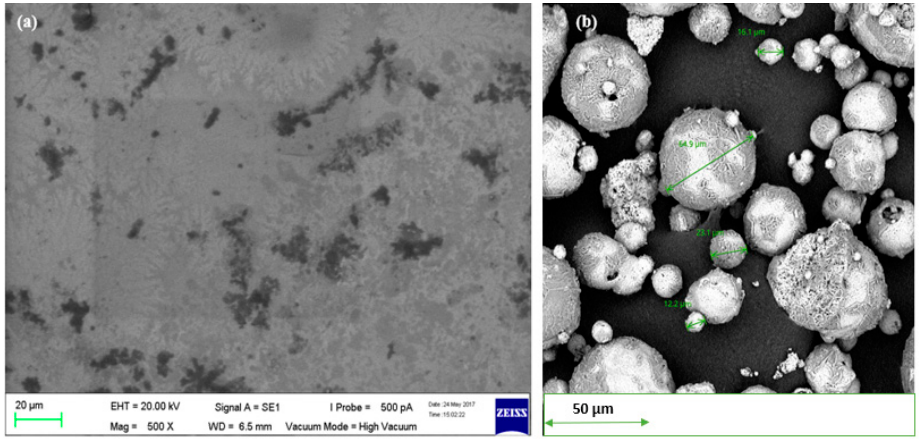
Figure 1. As-received Scanning Electron Microscopy (SEM) image: ( a ) Vit1b-X Zr 67 Cu 11 Ni 10 Ti 9 Be 3 bulk metallic glass (BMG) and ( b ) Micro-size hydroxyapatite powder.